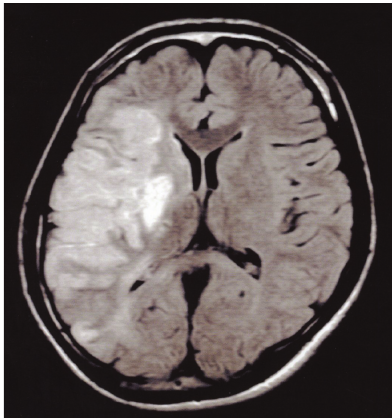
Figure 2: Axial fluid-attenuated inversion recovery magnetic resonance image showing cerebral infarction in the right cerebral hemisphere.